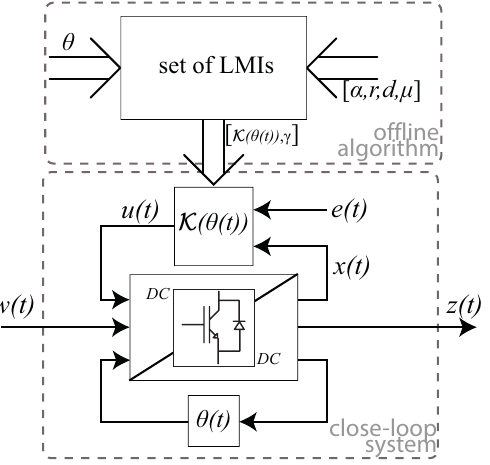
Figure 3. Scheme of design.